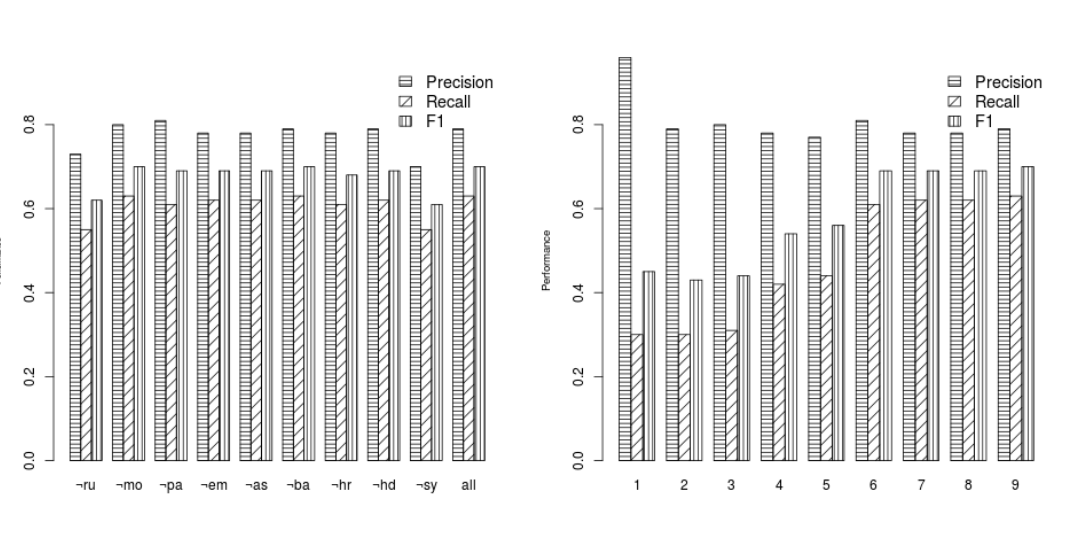
Figure 7: Evaluation of performance with different number of activate modules, using Dataset